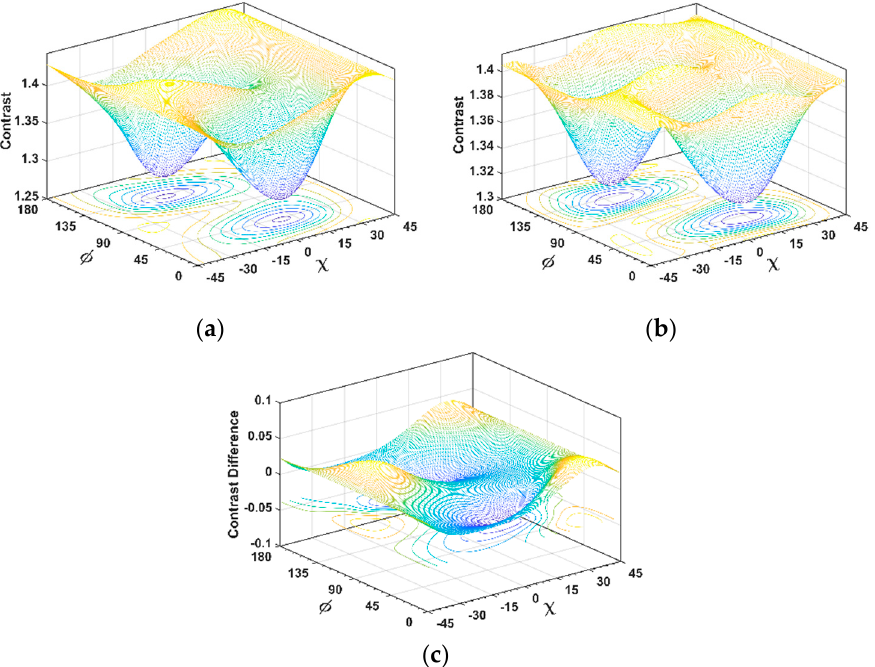
Figure 6. Polarimetric TomoSAR focusing capability for cell A: ( a ) Four-data stack, ( b ) nine-data stack, ( c ) polarization TomoSAR dispersion obtained through the subtraction of ( b ) from ( a ).